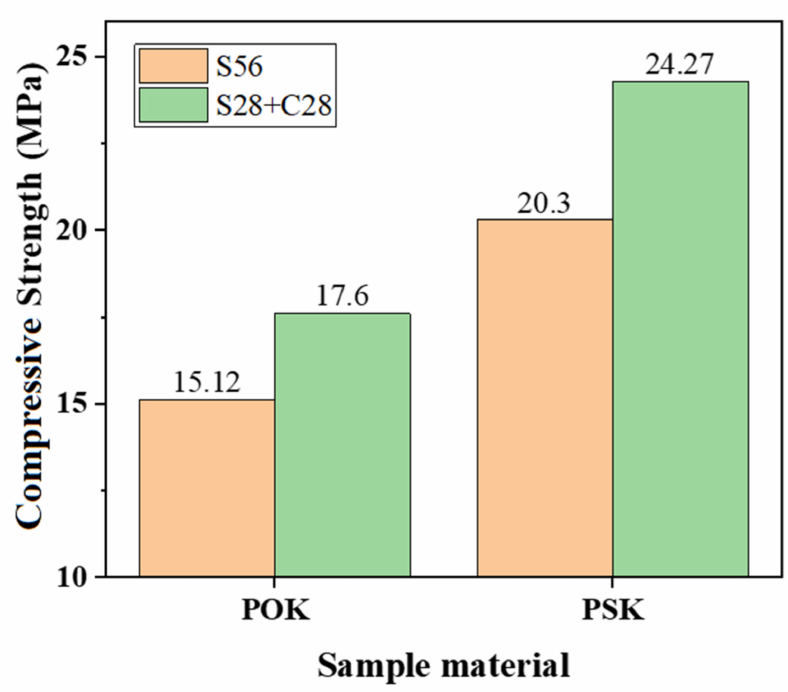
Figure 5. Uniaxial compressive strength of POK and PSK samples after S56 and S28 + C28